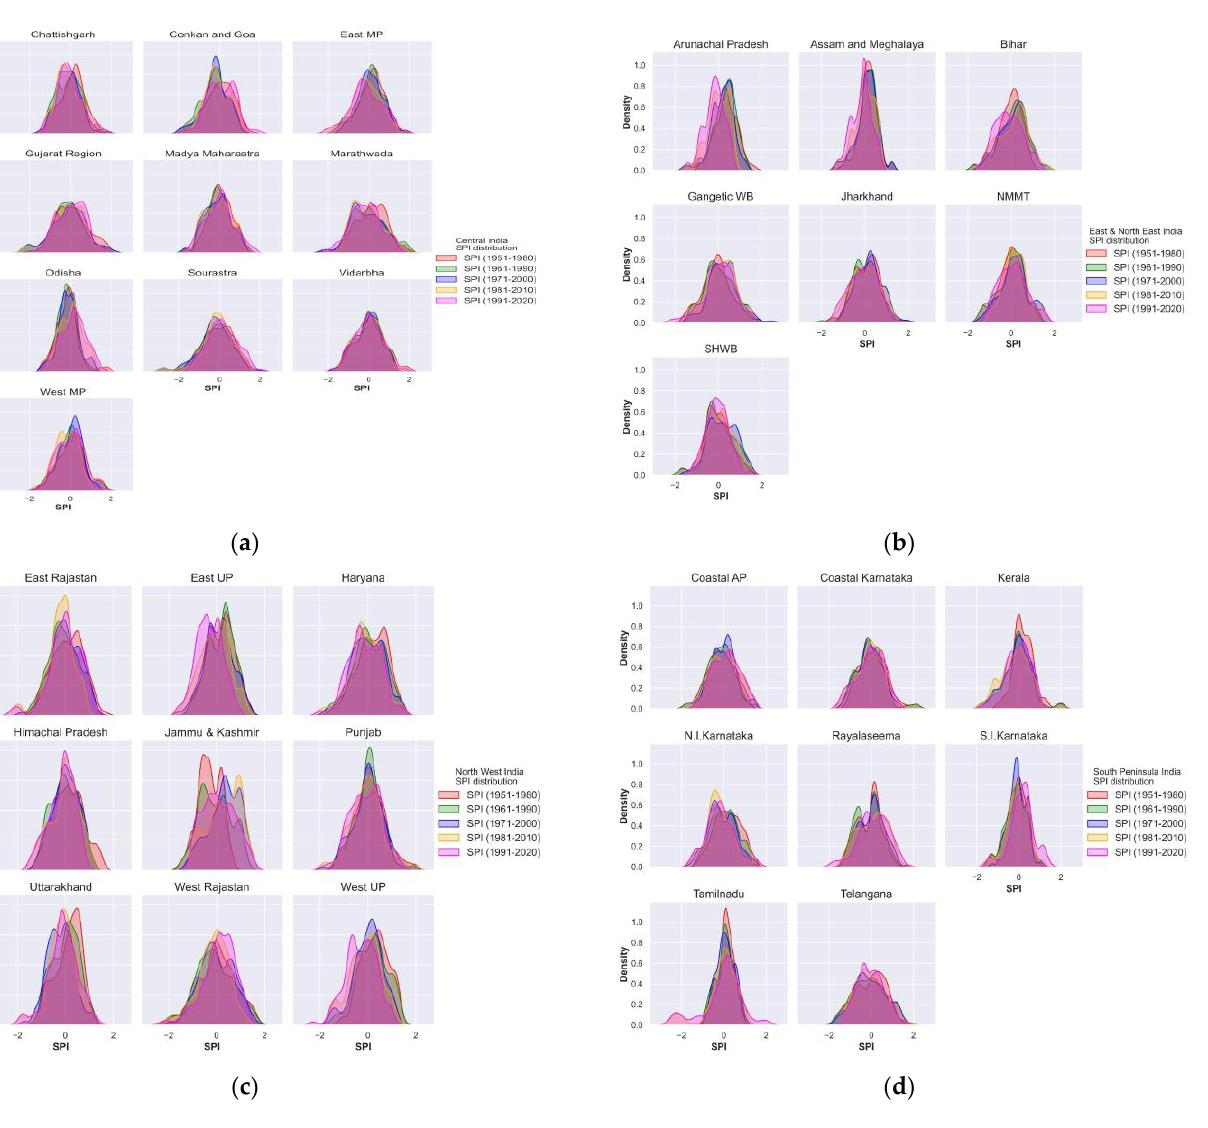
Figure 7. Interannual drought index decadal change probability density function (PDF) plot ( a ) Cen- tral India, ( b ) East and Northeast India, ( c ) Northwest India, and ( d ) South Peninsula India over Indian meteorological subdivision region for the period 1951 – 2020.